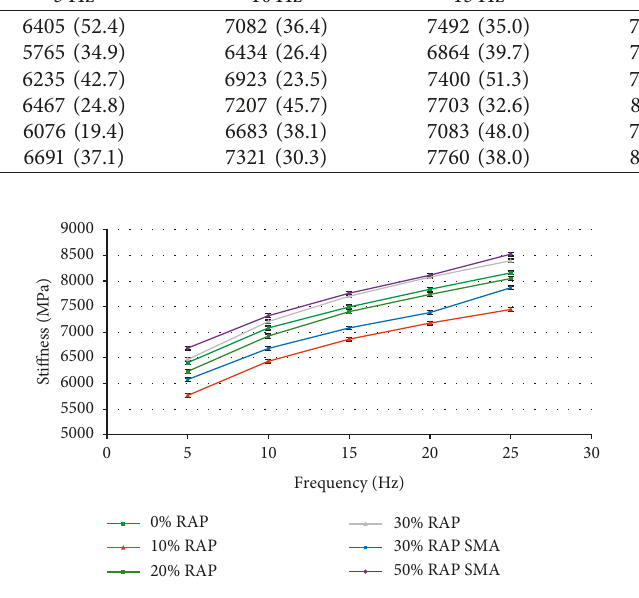
Figure 5: Stiffness of the individual SMA 11 mixture variants with various ratios and both types of RA. Table 7: Low-temperature parameters of SMA 11 mixtures with various ratios of RA (RAP and RAP SMA). Low-temperature properties based on EN 12697-46 Mixture Maximum tensile strength (MPa) Temperature at crack formation ( ° C) SMA 11 0% RAP 3.60